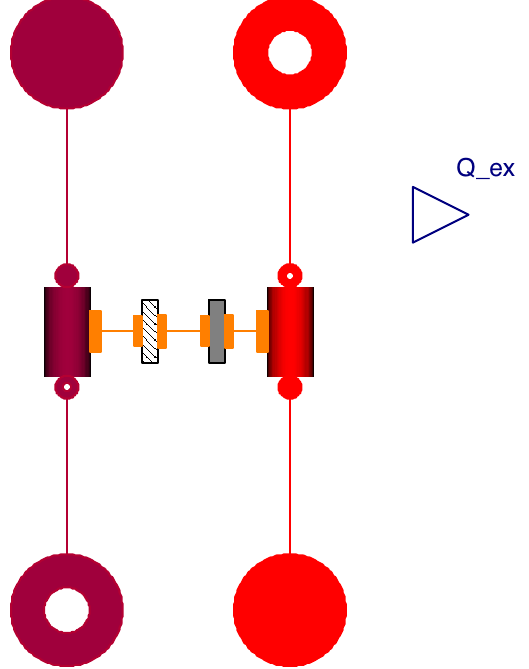
Fig. 7. Object-oriented Modelica model of the IHX.